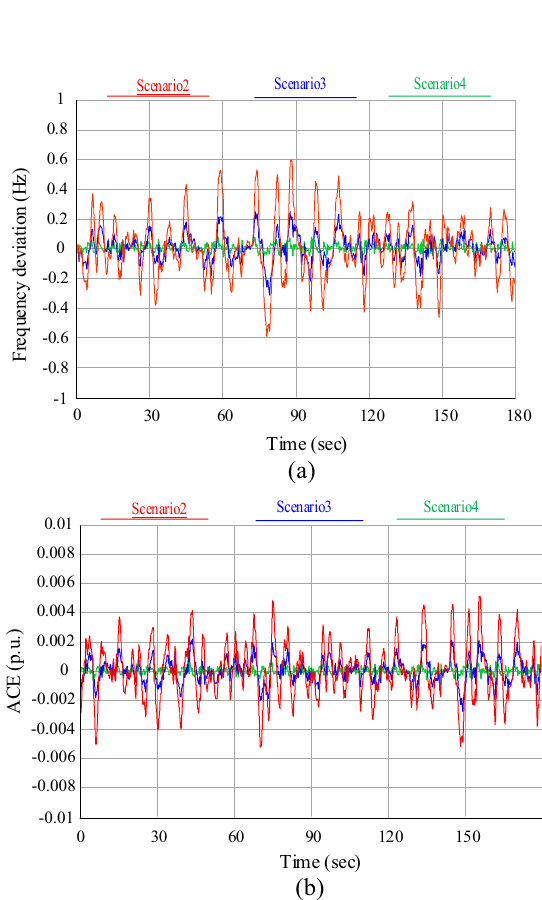
Fig. 12 Simulation results under random loads and wind speed, a system frequency deviation, b ACE deviation of area one